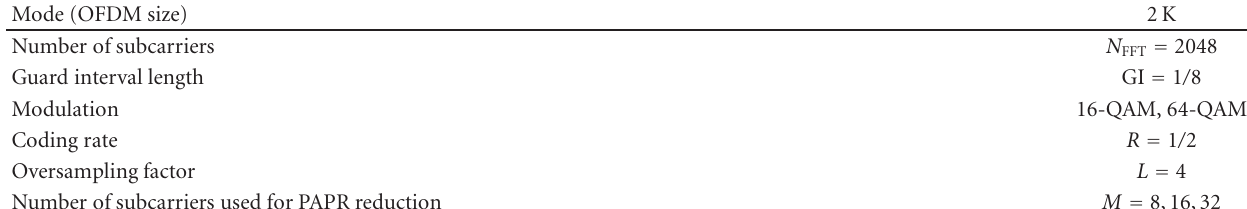
Table 1: Simulation parameters, extracted from DVB-T2 standard.